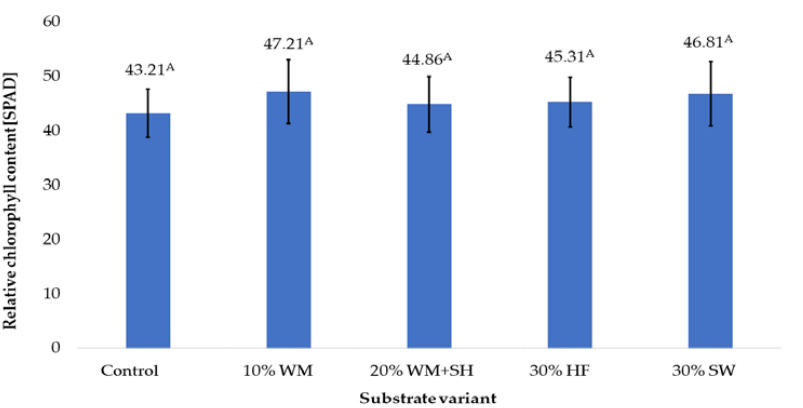
Figure 4. Relative chlorophyll content in raspberry fruits, depending on the substrate used (n =